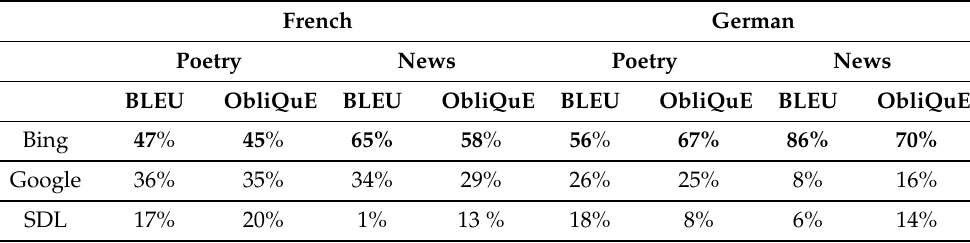
Table 2. Evaluation of three MT systems over 100 English poems and 100 news pieces. Each cell is the number of times that the specific MT system got the best score of the three MT systems, according to BLEU or ObliQuE . For example, out of 100 English poems that were translated to French and back to English, 47 poems received the highest BLEU score when using Bing for the forward-backward translation; 36 poems received the highest score using Google and 17 poems using